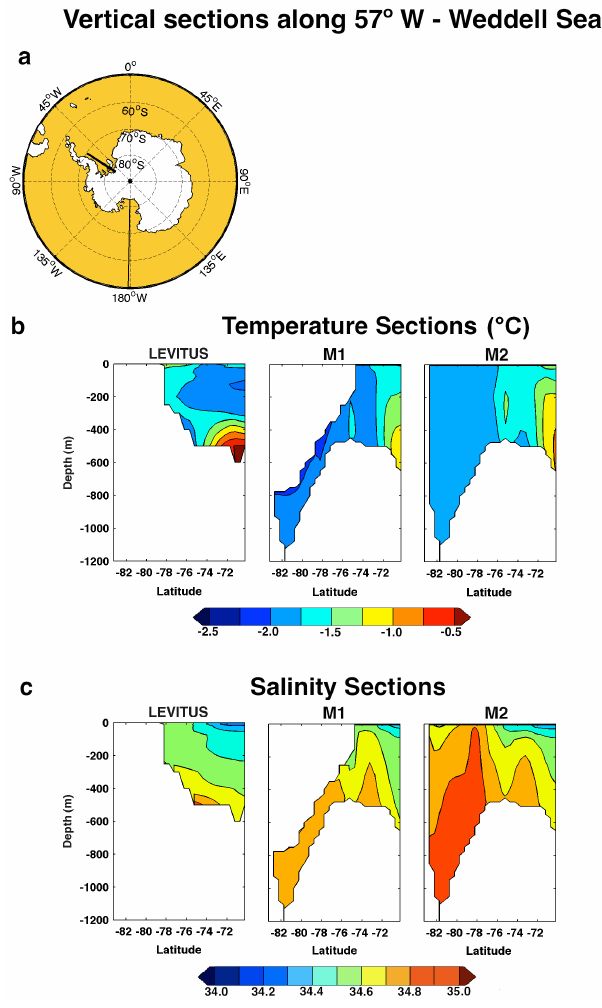
Fig. 6. Vertical sections along the Ronne Ice Shelf at 57 ◦ W (a) of the annual mean temperature (b) and salinity (c) for Levitus and model climatologies.